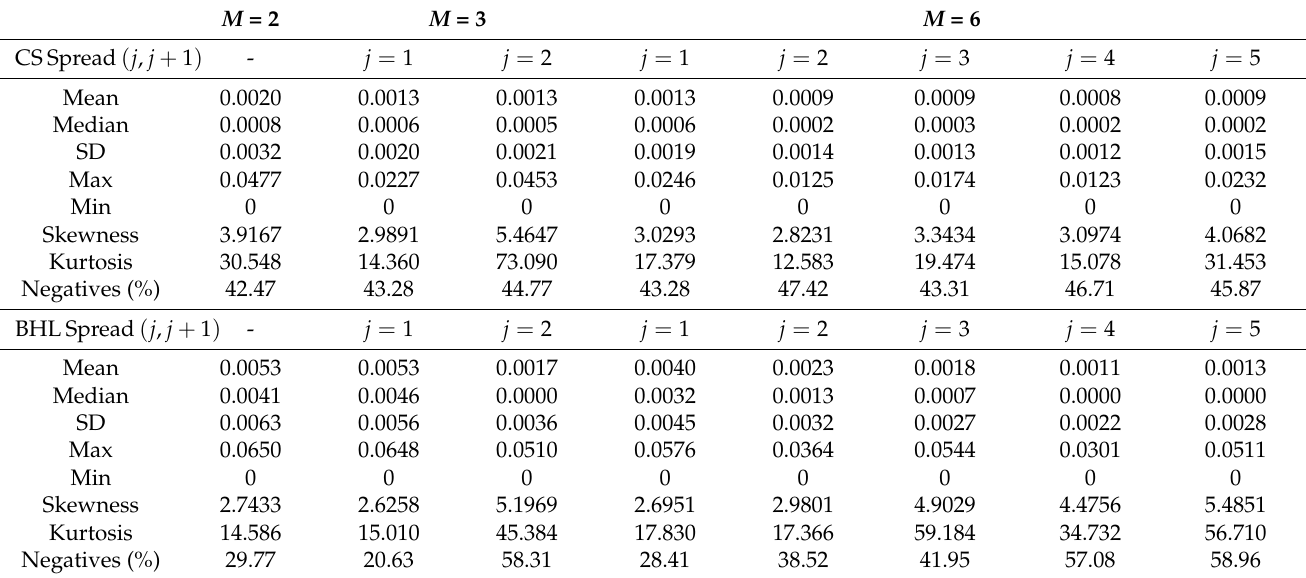
Table 9. Summary statistics of intraday spread measures.